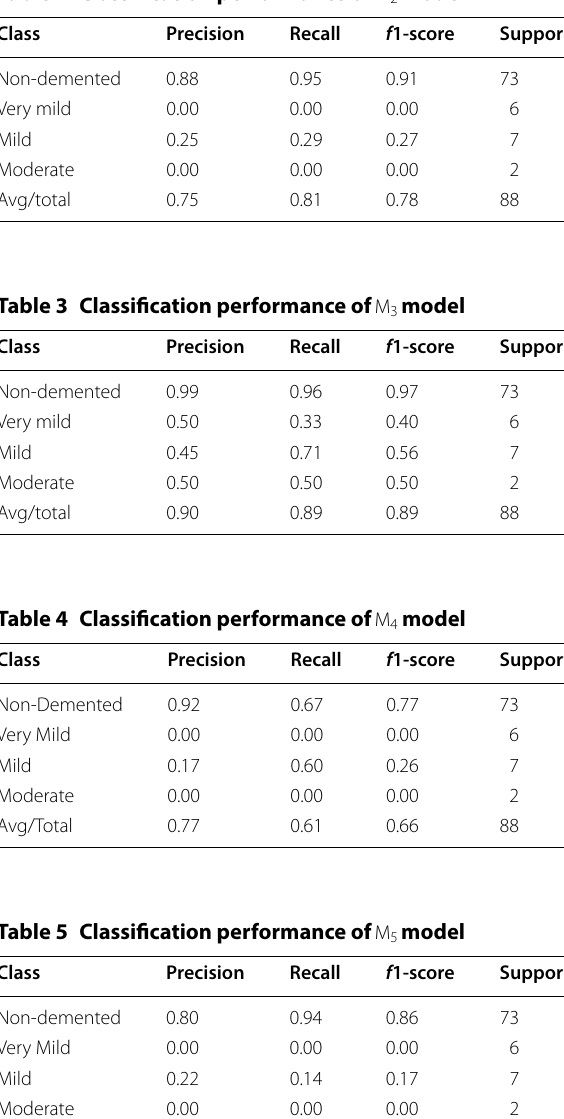
Table 2 Classification performance of M 2 model